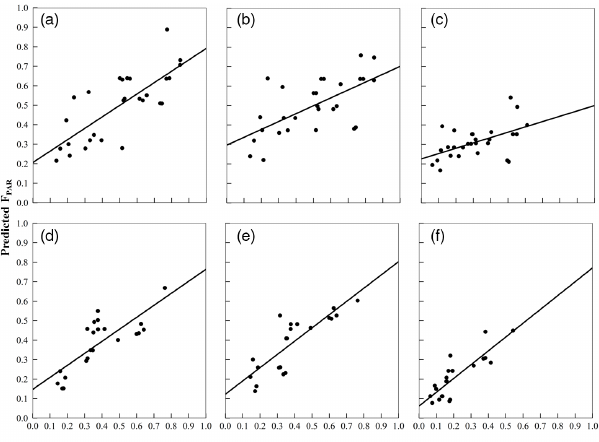
Figure 3. Scatter plots of the the fraction of photosynthetically ac- tive radiation intercepted by the canopy ( F par ) vs. Landsat F par for wheat (a–c) and pasture (d–f) estimated by the Global Inventory Modeling and Mapping Studies normalized difference vegetation index version 3, Vegetation Index and Phenology Lab version 3 normalized difference vegetation index, and Vegetation Index and Phenology Lab version 3 enhanced vegetation index 2. The solid lines represent the linear model used to downscale the vegetation record for evaluation with in situ leaf area